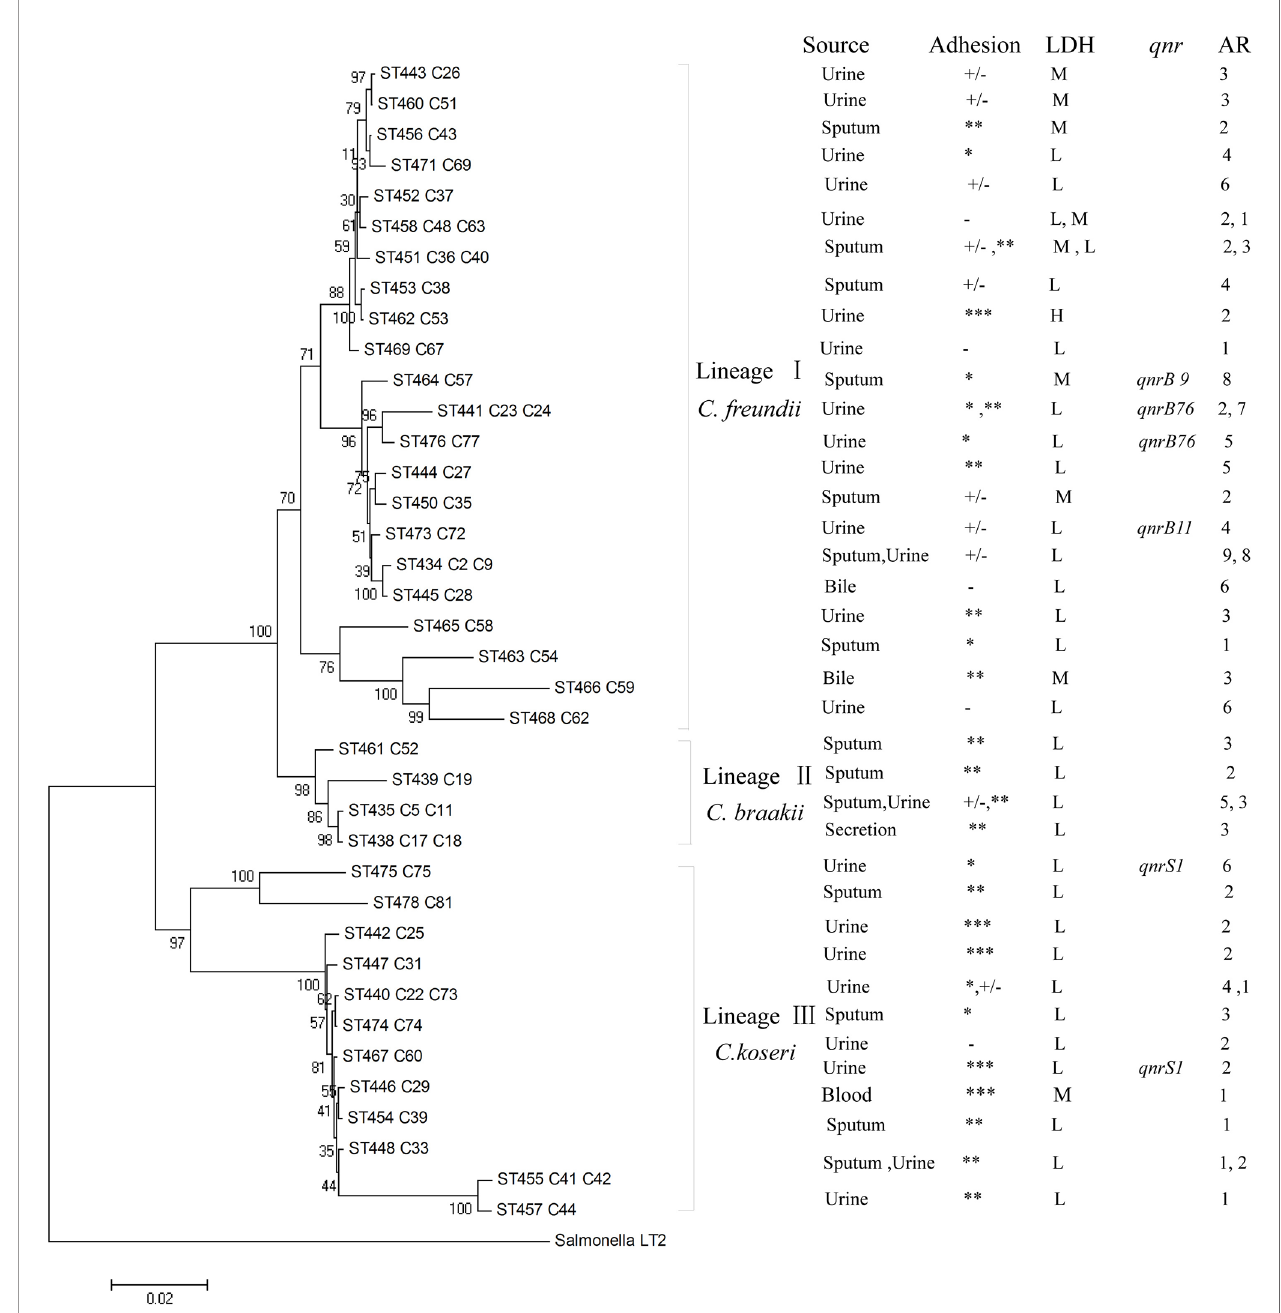
FIGURE 2 | Phylogenetic relationships of the 46 Citrobacter isolates as determined by MLST data. The isolates were fi rst marked with ST number followed by isolate name or names if more than one isolate. The presence of qnr genes, AR denoting antibiotic resistance with number of drugs resistant to, adhesion, LDH, and source among Citrobacter isolates were shown on the right. Note that for any STs with two isolates, properties for both were listed and separated by a comma. The tree was constructed using neighbor joining algorithm. ST and LDH indicate sequence types and lactate dehydrogenase, respectively. Cluster divisions are marked. Numbers on or near the nodes are bootstrap values from 1,000 replicates. Adhesion index: ***, >50; **, >1 and <50; *, <1; +/ ‐ , ambivalent or no adhesion; ‐ , no adhesion. Under LDH for cytotoxicity: H denotes highly cytotoxic if LDH values of >24%; M for intermediately cytotoxic if values from 18% to <24%; L for lowly or non-cytotoxic if LDH values from 1.4% to 17.8%. See Table 2 for actual